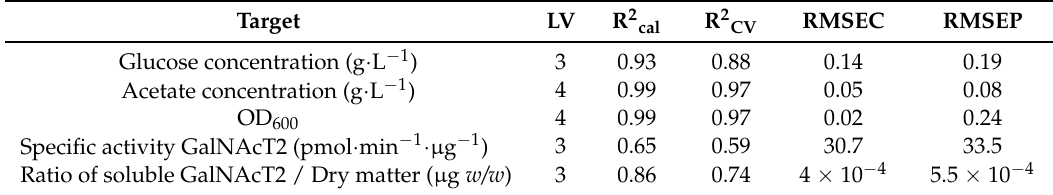
Ratio of soluble GalNAcT2 / Dry matter ( µ g w/w